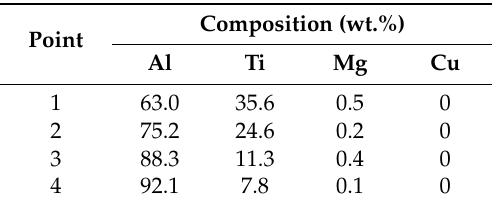
Figure 11. An XRD spectrum of the mixed powder bulk heated for 0 min and 60 min at 640 °C. Table 2. Compositions of the points shown in Figure 10.